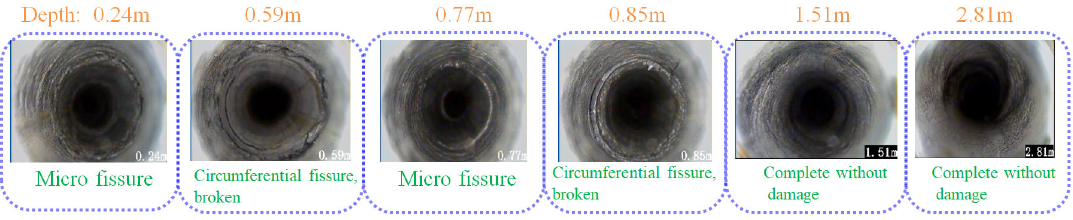
Figure 14. Distribution of separation fractures in the roadway roof under the new supporting technology.